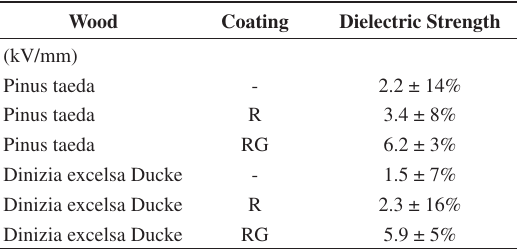
Table 3. Dielectric strength of uncoated and coated samples. Wood Coating